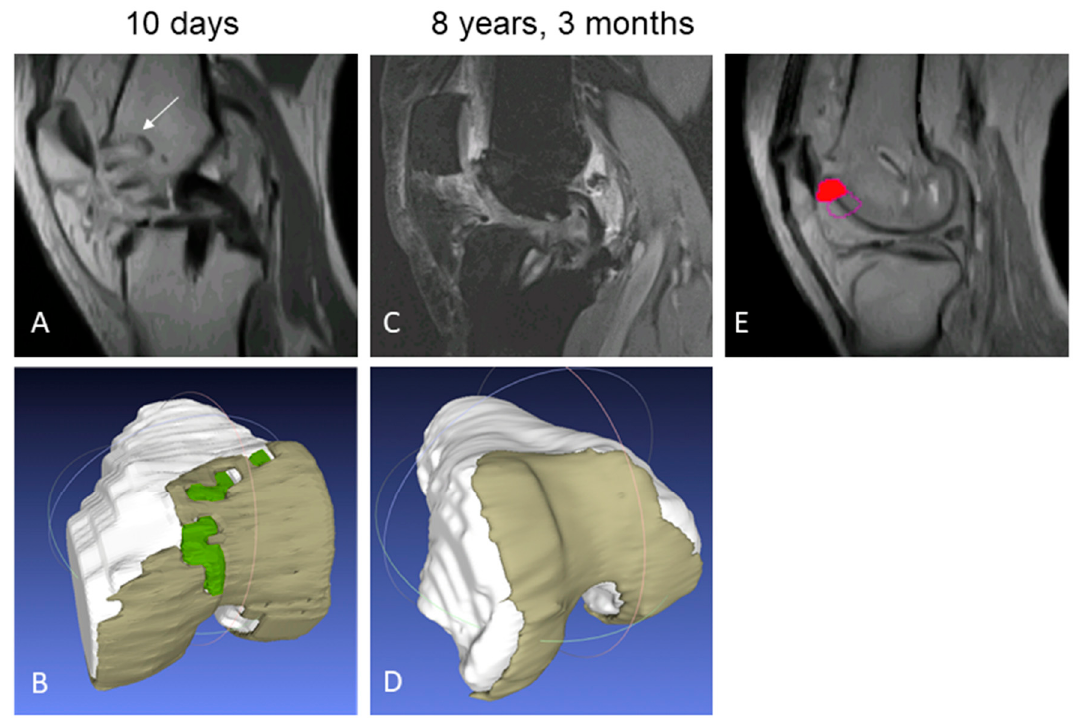
Figure 2. Longitudinal MRI reconstruction of a ChondroMimetic-treated subject knee at 10 days ( A , B ) and 8 years, 3 months ( C , D ). ( A ) By 2D MRI, 5 ChondroMimetic implants can be observed with hyper-intense peri-implant boundaries, and lack of cartilage-like signal (white arrow). ( B ) 3D rendering of knee yields ChondroMimetic implants (green) surrounded by cartilage (brown) by automated software based on MRI signal. ( C ) At the follow-up after 8 years and 3 months, treated bone defects are filled with bony repair tissue and the treated cartilage defect is filled with cartilaginous repair tissue. ( D ) Automated rendering demonstrates cartilaginous tissue in repaired defects congruous with surrounding cartilage. ( E ) The trochlear control region of interest (filled red circle) of native cartilage used for T2 relaxation time comparison. The open purple circle shows an unused, alternate control region of interest.